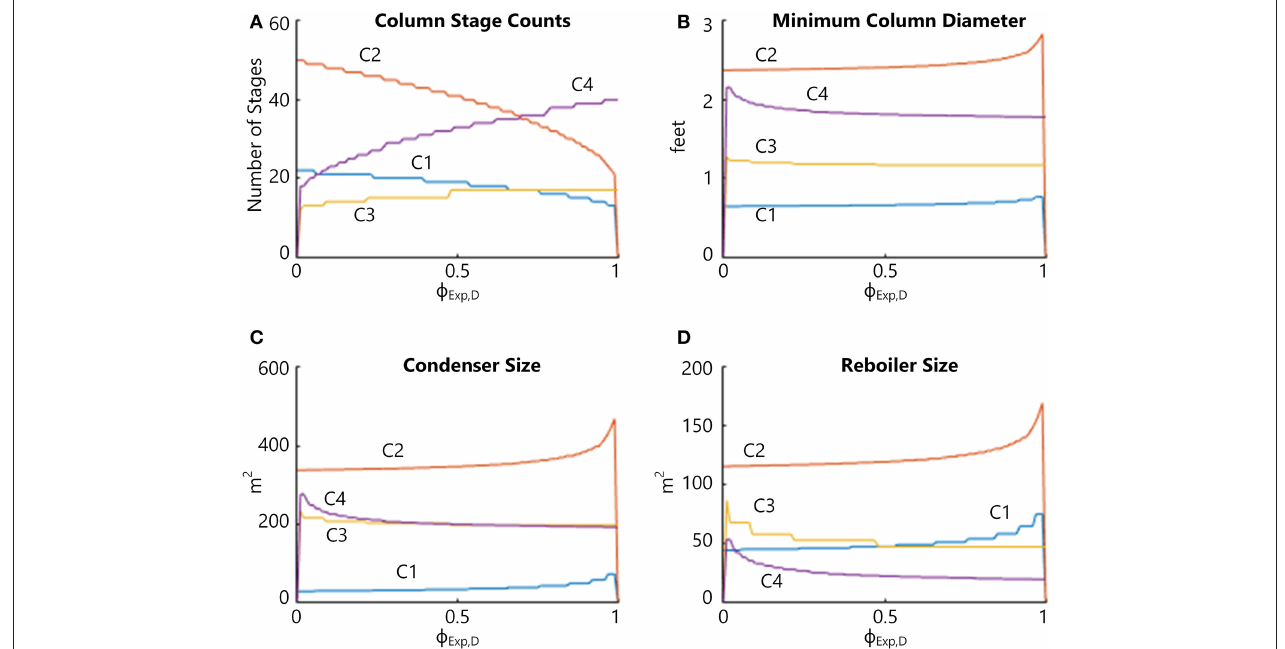
FIGURE 5 | Selected optimal design parameters for the Base Case as a function of φ Exp , D . (A) The number of stages of each distillation column ( N A , c + N B , c ). (B) The minimum diameter of each distillation column before rounding up to the nearest 0.5 ft (0.152m). increment ( D c ). (C) The surface area of the condenser of each distillation column ( A C , c ). (D) The same for the reboiler ( A H , c ).